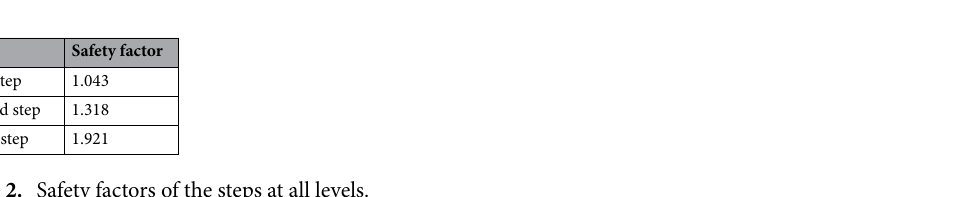
Figure 8. The position of the sliding surface of the steps at all levels (unit: m).